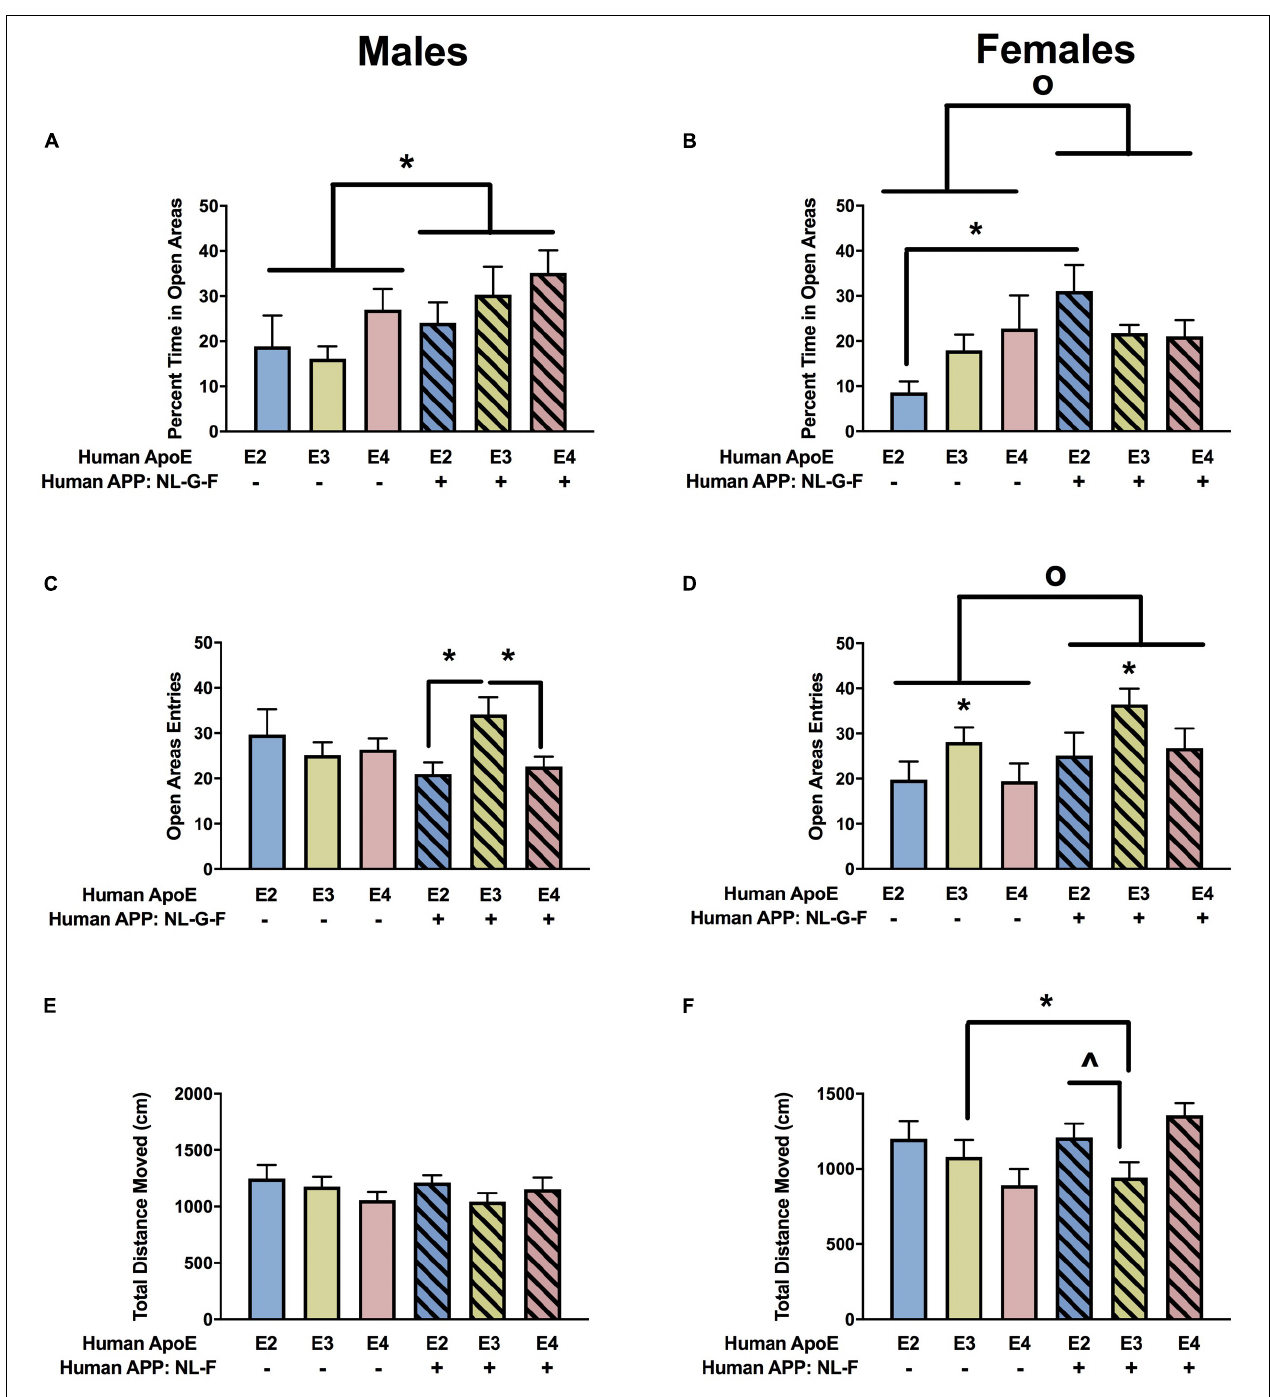
FIGURE 3 | Performance of males (A,C,E) and females (B,D,F) in the elevated zero maze at the 6-month time point. (A) There was an effect of APP on measures of anxiety in males. Measures of anxiety were lower in NL-G-F mice. * p < 0.05. (B) There was an effect of APP and an APP × APOE interaction for measures of anxiety in females. Measures of anxiety were lower in NL-G-F mice. o p = 0.023. In addition, measures of anxiety were lower in NL-G-F/E2 than E2 females. * p < 0.05. (C) There was an APP × APOE interaction for entries into the open areas in males. NL-G-F/E3 males entered the open areas more than NL-G-F/E2 and NL-G-F/E4 males. * p < 0.05. (D) There was an effect of APP and APOE on entries into the open areas in females. NL-G-F females entered the open areas more often. o p = 0.039. In addition, measures of anxiety were lower in E3 than E2 and E4 females. * p < 0.05. (E) Activity levels of males in the elevated zero maze. (F) There was an APP × APOE interaction for activity levels of females in the elevated zero maze. E3 females were more active than NL-G-F/E3 females. * p < 0.05. In addition, NL-G-F/E3 females were less active than NL-G-F/E2 and NL-G-F/E4 females. ∧ p < 0.05.